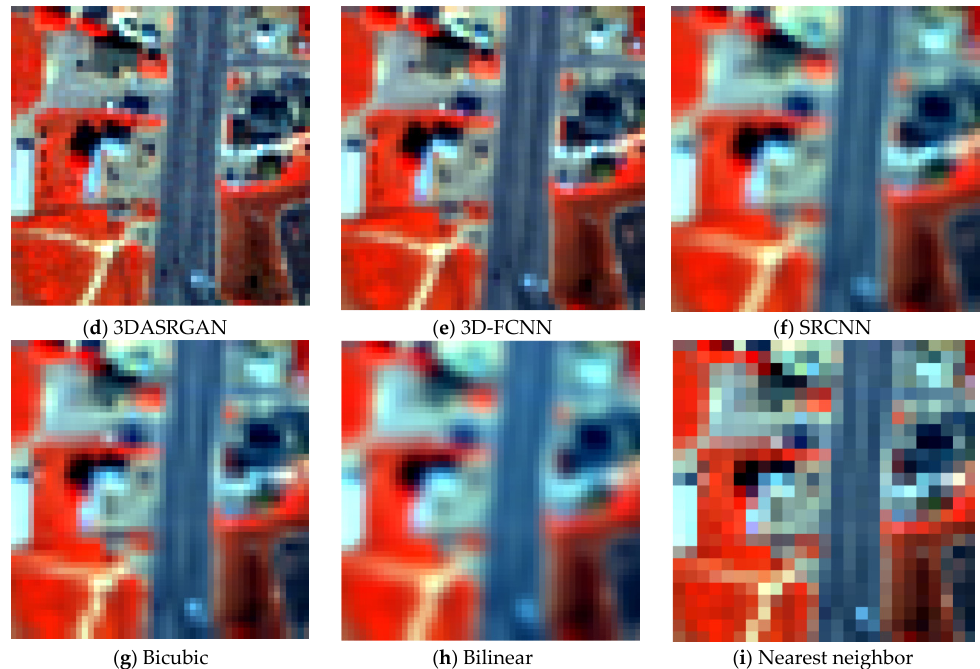
Figure 8. Image parts produced by various SR HSI methods and original LR and HR images based on the Urban dataset.